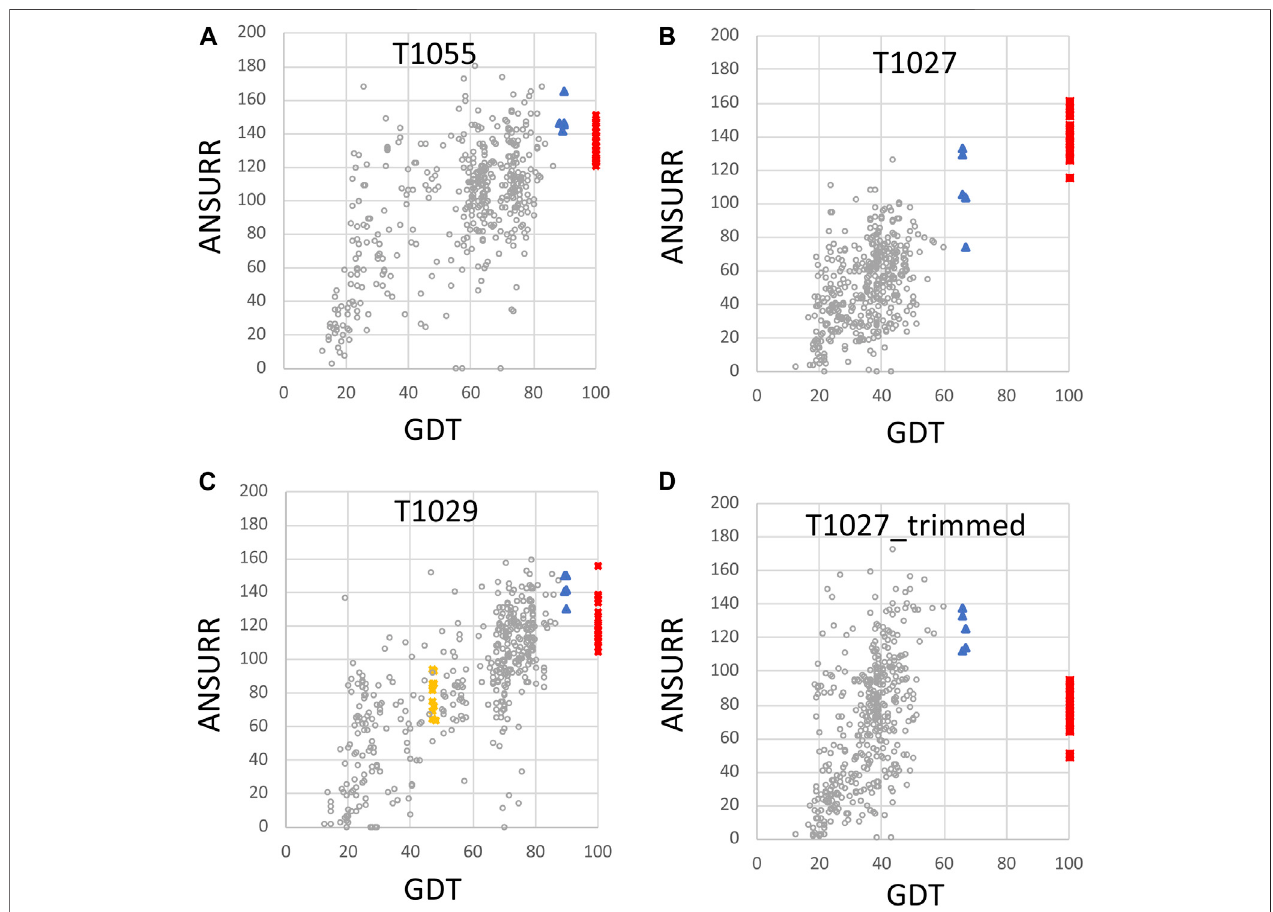
FIGURE 4 | Plots of ANSURR composite score vs. GDT for NMR and AlphaFold models. The data of Figure 3 were replot to compare the sum of ANSURR correlation and RMSD scores vs. GDT (Huang et al., 2021). Plots are provided for CASP14 targets (A) T1055 (linear correlation coef fi cient r 2 = 0.35), (B) T1027 (r 2 = 0.47), (C) T1029(r 2 =0.57;datashownforbothT1029_originalandT1029_revisedNMRstructures),and (D) T1027_trimmed(residues36 – 75and96 – 145,r 2 =0.11)in which coordinates are trimmed to remove the structurally not-well de fi ned or unreliably predicted polypeptide segments. In each panel, the open circles are the CASP 14 prediction models (excluding AF models), red squares are the fi nal NMR structure models deposited in the PDB, blue triangles are AF prediction models, and yellow squares are for the original NMR structures of target T1029, before revised analysis of NOESY data.